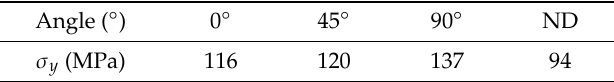
Table 3. Strength of the magnesium AZ31